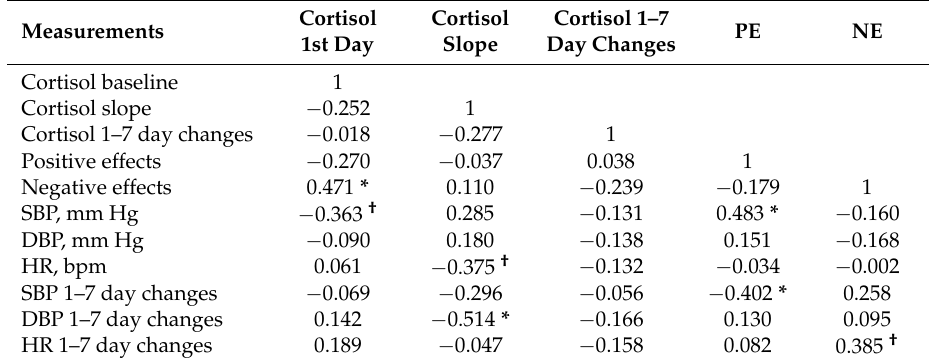
Table 2. The relationships between cortisol, mood, and hemodynamic parameters (Spearman’s correlation